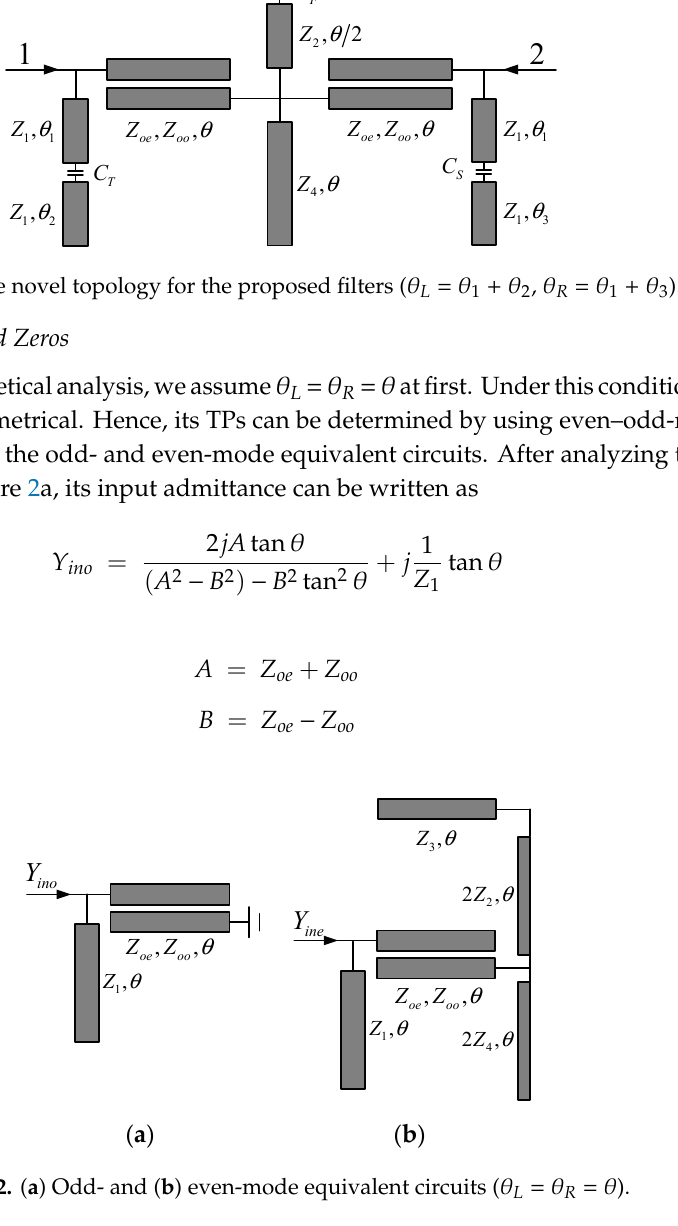
Figure 2. ( a ) Odd- and ( b ) even-mode equivalent circuits ( θ L = θ R = θ ).